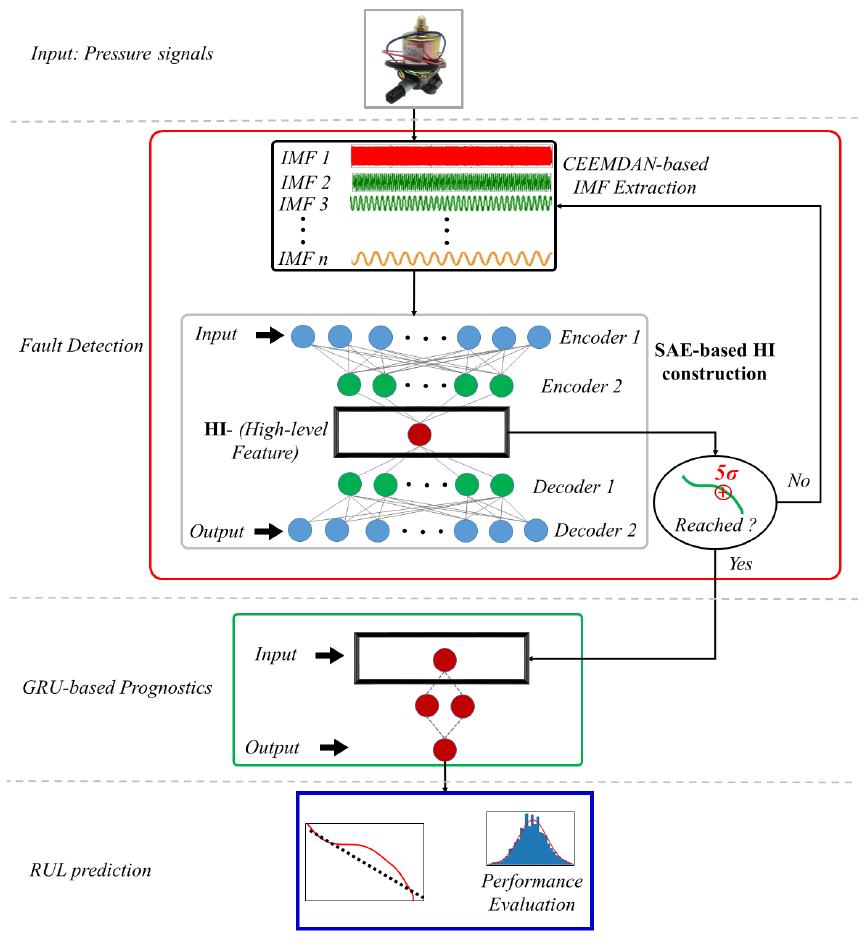
Figure 1. Proposed RUL prediction